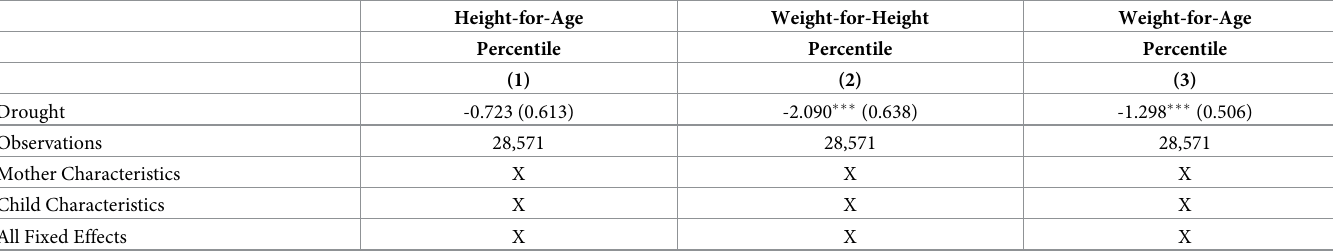
Table 6. Prenatal exposure to droughts and child health—Other outcomes 2.